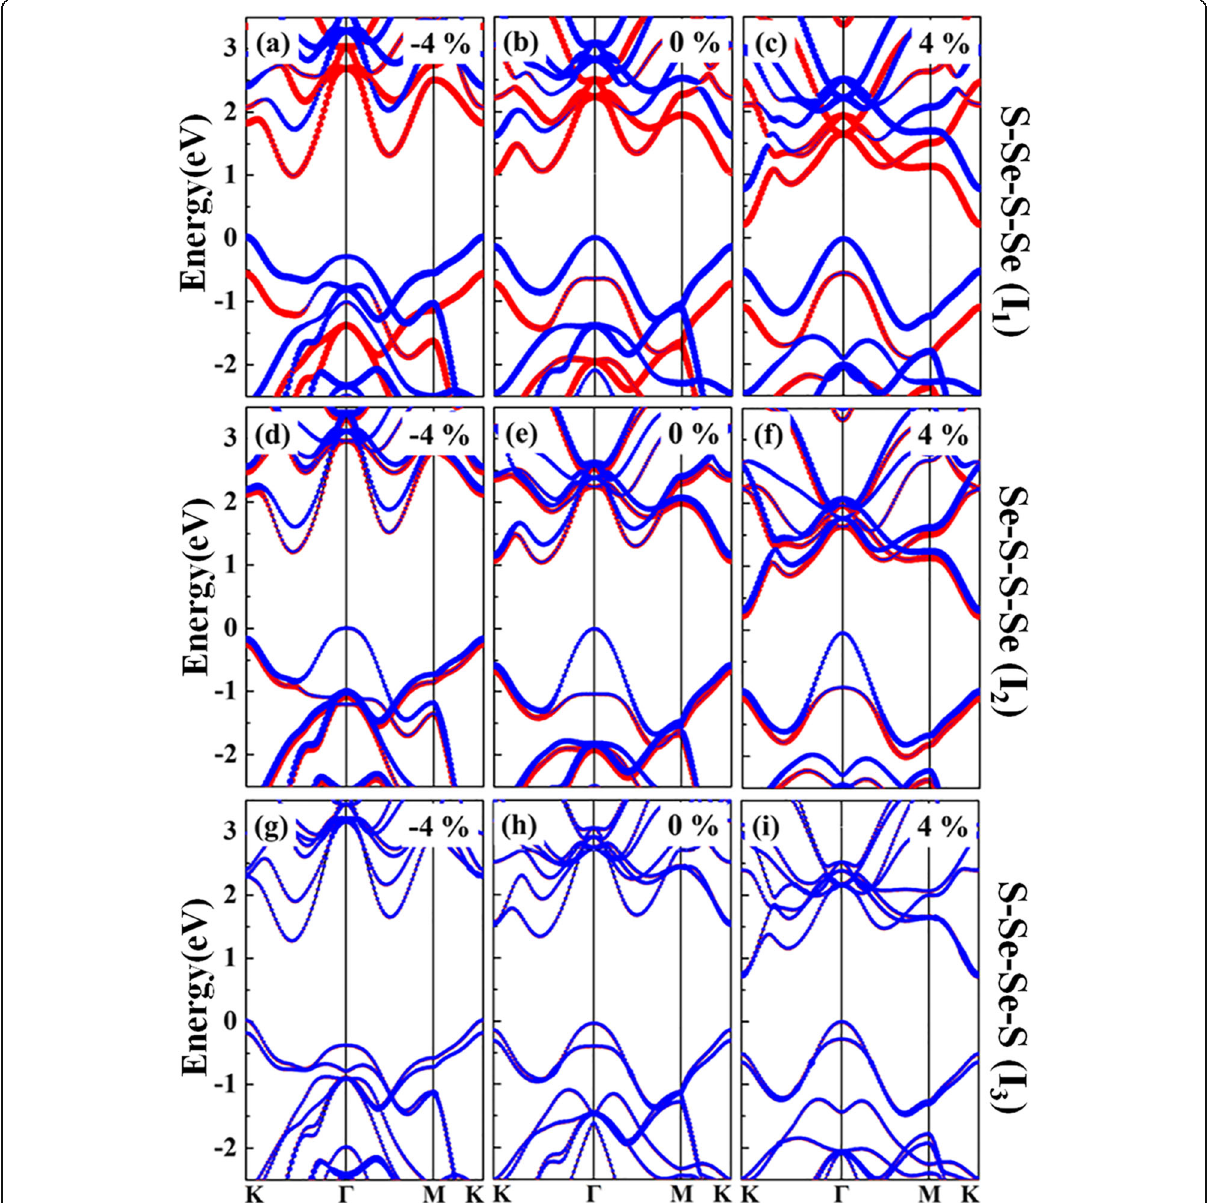
Fig. 6 Atomic orbital projected energy bands of I 1 , I 2 , and I 3 structures under the strains of − 4%, 0, and 4%, respectively. Blue and red colors mean orbital contributions from the upper and the lower layers,